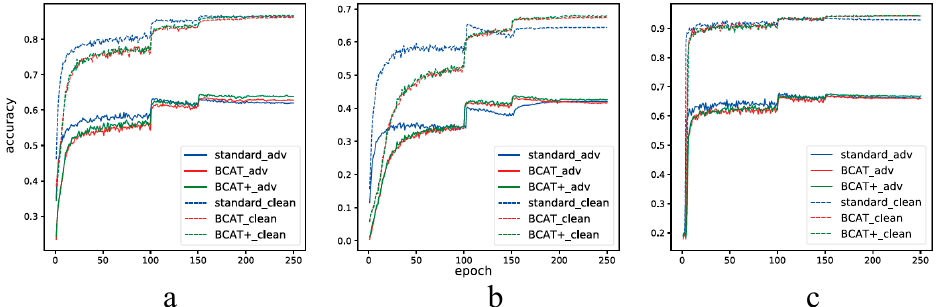
Figure 9. The convergence of the testing accuracy on clean examples and adversarial examples for CIFAR-10, CIFAR-100, and SVHN. ResNet34, WRN34–5, and ResNet18 are used for CIFAR-10, CIFAR-100, and SVHN, respectively. ( a ) CIFAR-10. ( b ) CIFAR-100. ( c ) SVHN.